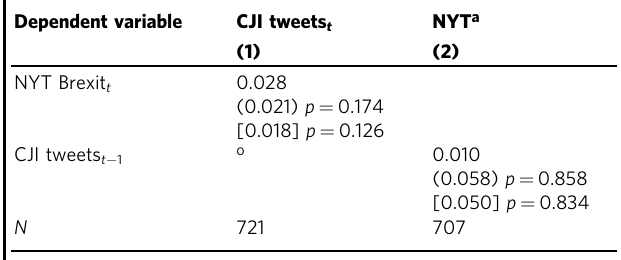
Table 3 Predicting diversionary tweets (CJI) from Brexit media coverage (column 1) and predicting suppression from diversionary tweets (column 2).